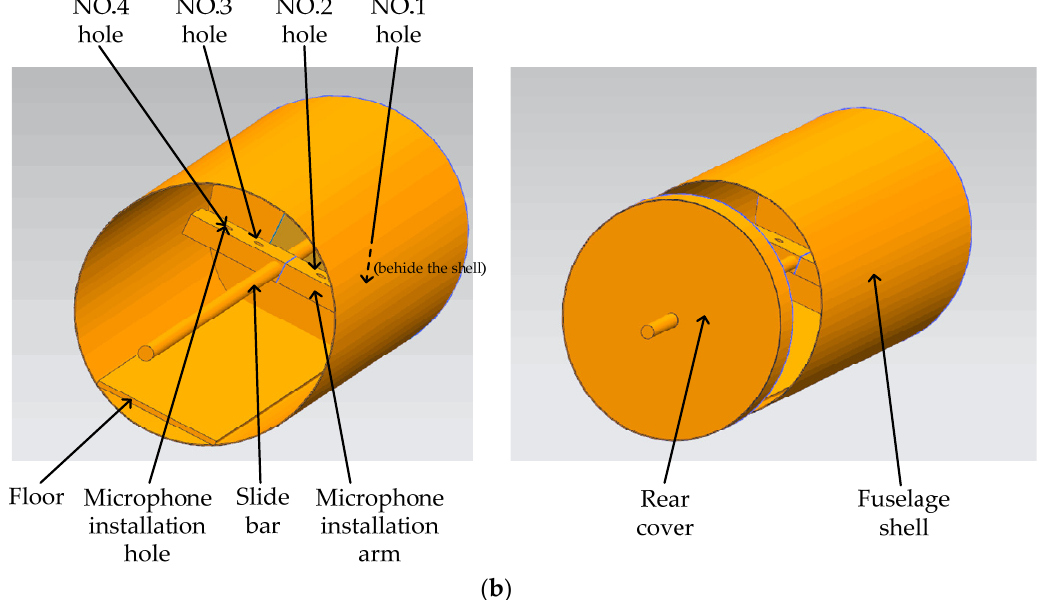
Figure 2. Propeller synchrophasing control experimental platform: ( a ) Overall structure of the platform; ( b ) Cabin interior structure.